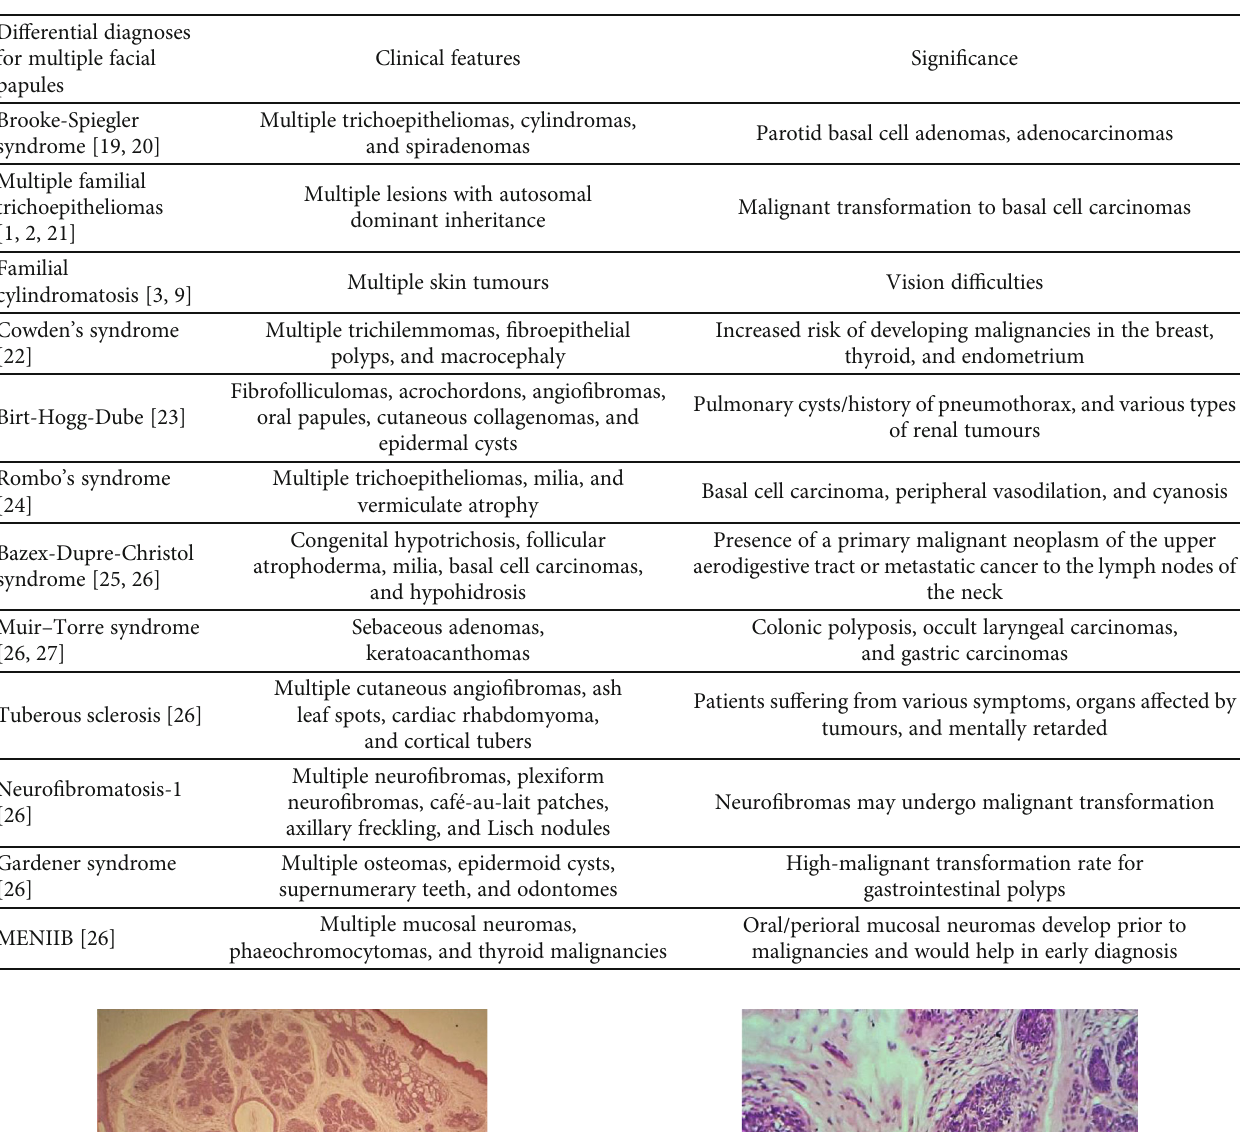
Table 1: Di ff erential diagnoses for multiple facial papules.